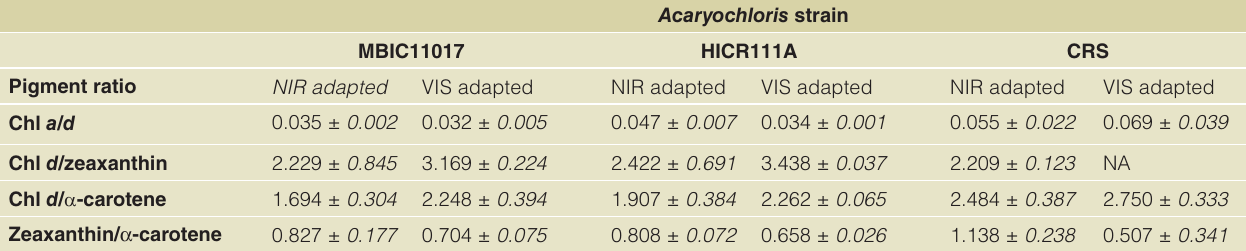
Table 1. Photopigment content of the three Acaryochloris strains MBIC11017, HICR111A and CRS. The strains were adapted to either visible light (VIS) or far-red light (NIR). Photopigments were identified manually from HPLC chromatograms and ratios calculated based on the derived peak areas. Average values and standard error from the mean from two independent growth experiments are